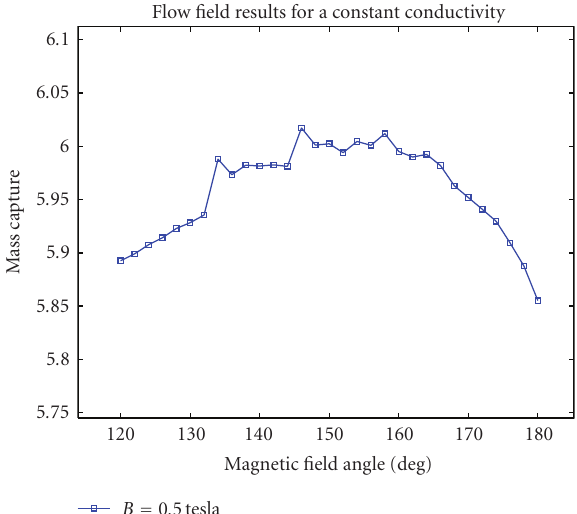
Figure 12: Zoom in of peak values for the moving ionization